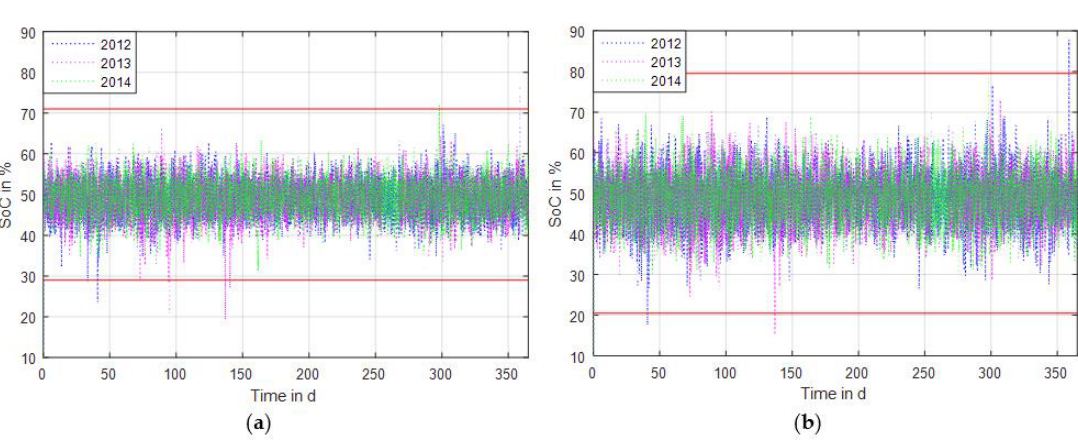
Figure 8. SoC curves and SoC limits (red lines) generated via validation simulations: ( a ) 30-min-criterion; and ( b ) 15-min-criterion.